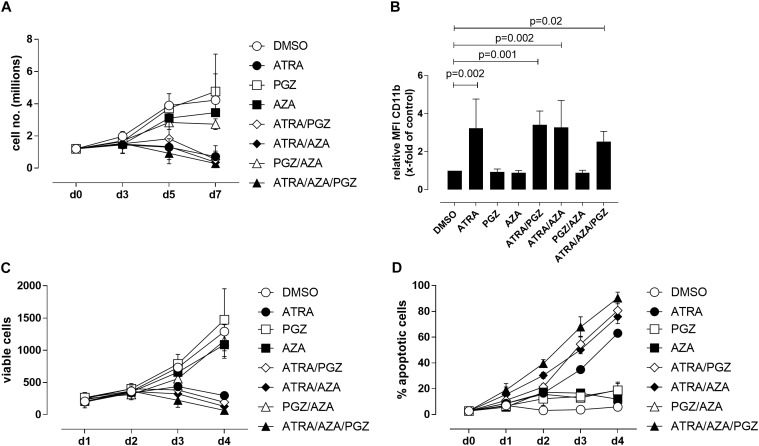
Treatment of HL-60 and U937 cells. (A) HL-60 cells (1.2 × 106) were incubated in RPMI supplemented with 10% FCS and as indicated with DMSO (open circles), 1 μM ATRA (closed circle), 5 μM PGZ (open square), 0.1 μM AZA (closed square), ATRA/PGZ (open diamond), ATRA/AZA (closed diamond), PGZ/AZA (open triangle), or ATRA/AZA/PGZ (closed triangle). On days 3, 5, and 7 during treatment, cells were counted by trypan blue staining. Data represent means of cell numbers from three independent experiments. Error bars indicate the standard deviation. (B) HL-60 cells were treated as described in (A). On day 5 of treatment, cells were characterized for surface-expression of the differentiation marker CD11b by flow cytometry. Shown are relative MFI values calculated by division of the MFI of antigen staining by the MFI of DMSO staining. Data represent means and standard deviations of three independent experiments. p-Values are shown for samples with significant differences in comparison to DMSO controls. Statistical analysis for group differences were performed using Friedman and Dunn’s multiple comparisons test. (C,D) U937 cells were incubated in RPMI supplemented with 10% FCS and as indicated with DMSO (open circles), 1 μM ATRA (closed circle), 5 μM PGZ (open square), 0.1 μM AZA (closed square), ATRA/PGZ (open diamond), ATRA/AZA (closed diamond), PGZ/AZA (open triangle), or ATRA/AZA/PGZ (closed triangle). From day 0 to day 4 during treatment, cells were analyzed for cell growth (C) and apoptosis (D). Data represent means from two independent experiments. Error bars indicate the standard deviation.